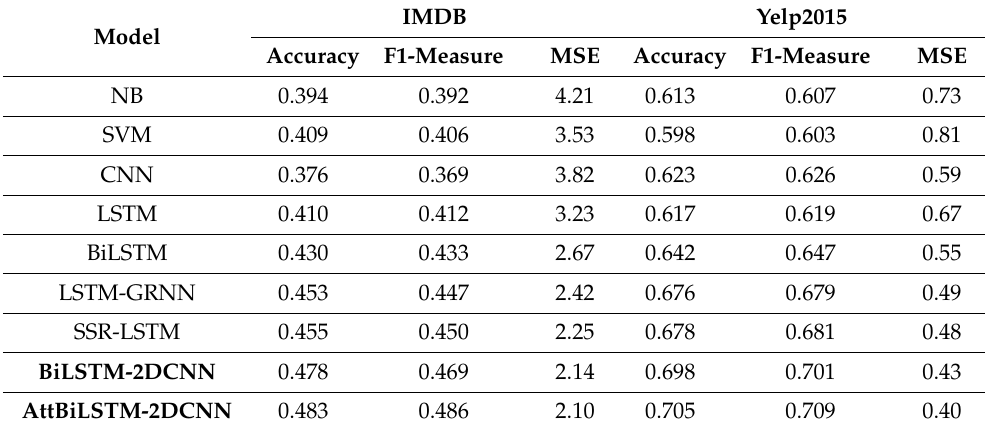
Table 2. Result of our model against certain competitive models on IMDB and Yelp. Accuracy (higher is better), F1-Measure (higher is better), and MSE (lower is better) are evaluation metrics.